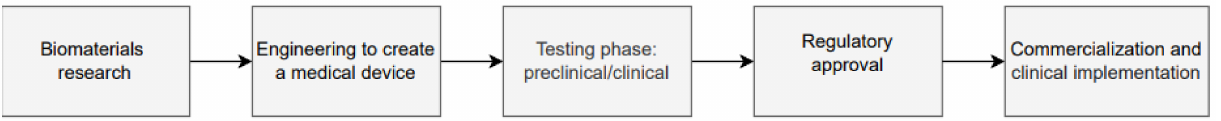
Figure 1. Steps that are mandatory to bring potentially innovative biomaterial technology to an implantable